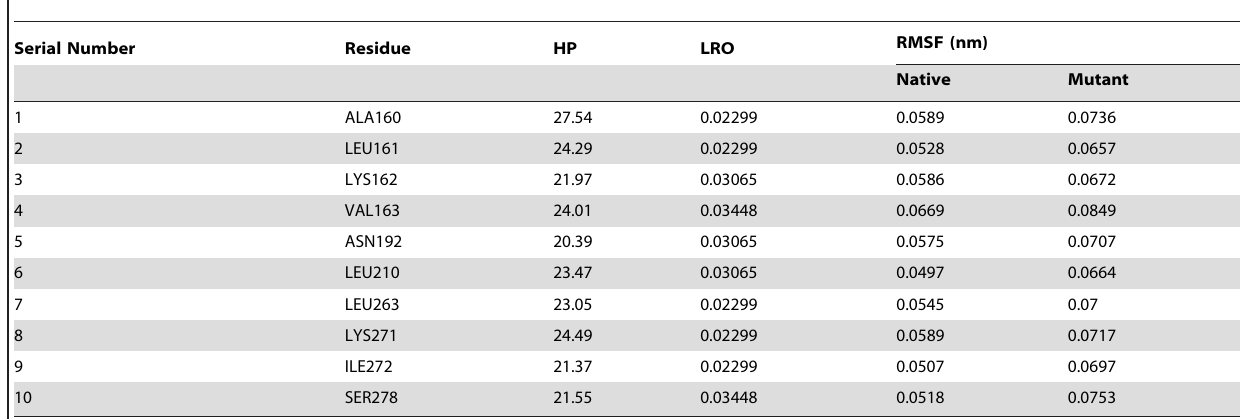
Table 4. The RMSF values of stabilizing